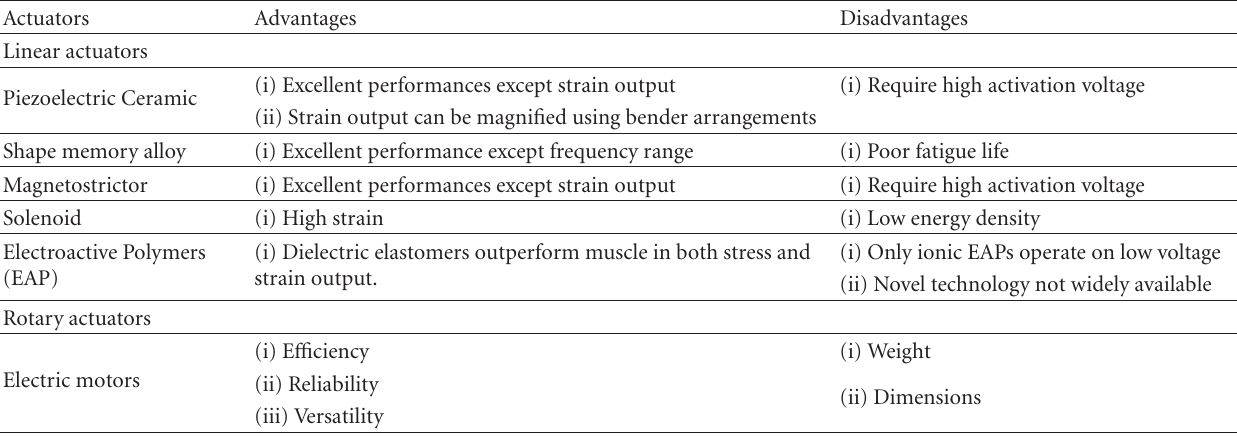
Table 4: Quality comparison of actuators: adapted from [35, 79].